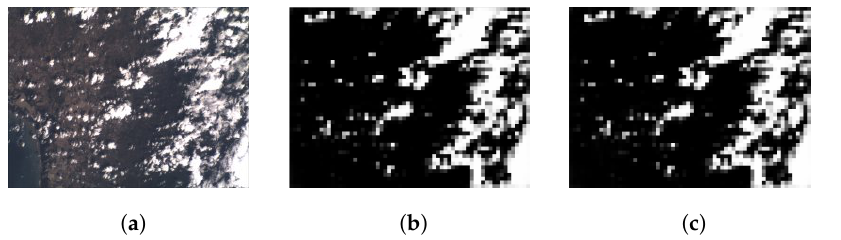
Figure 7. Comparison of cloud mask obtained from PC and from Embedded device. ( a ) Original Image; ( b ) Result obtained from NU-Net-mod in PC; ( c ) Result obtained from NU-Net-mod in Embedded device.